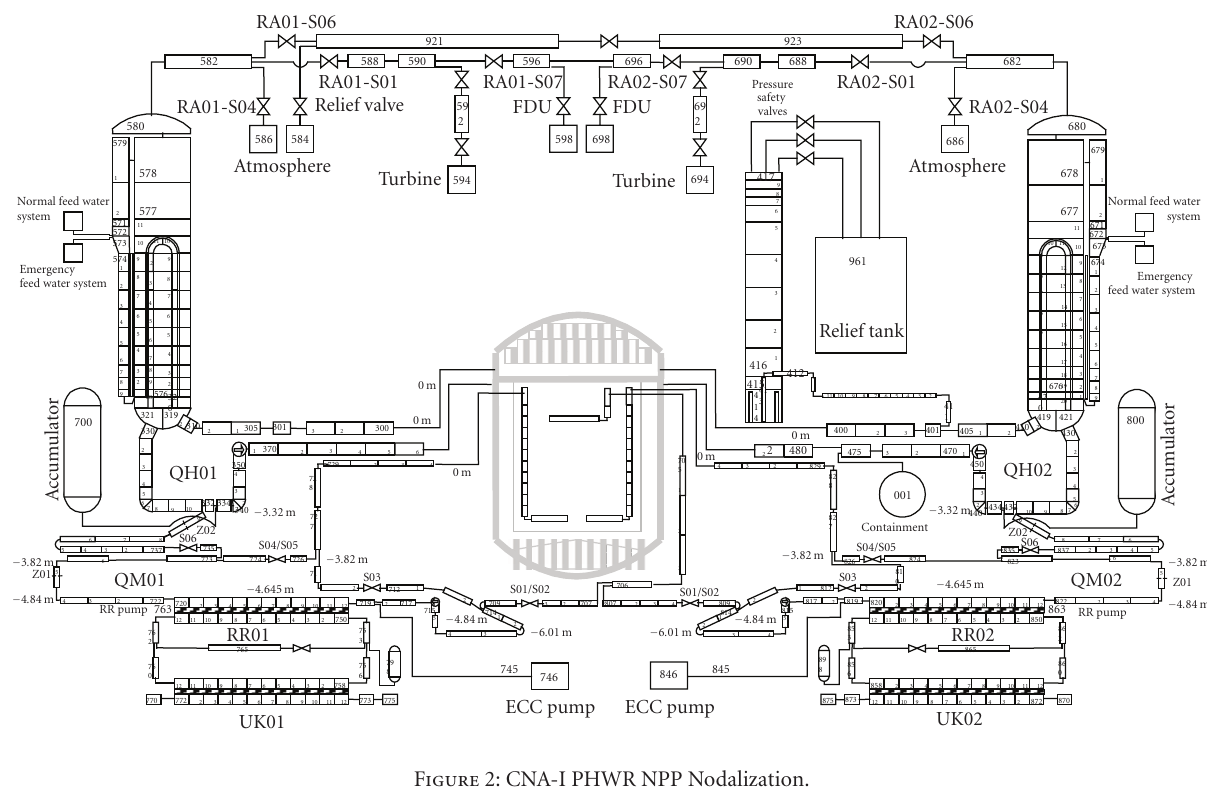
Figure 2: CNA-I PHWR NPP Nodalization.